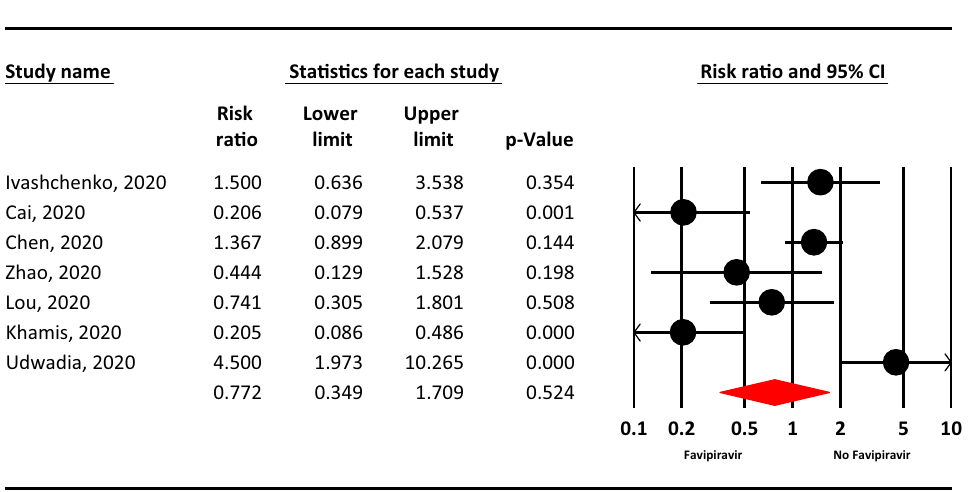
Figure 5. The meta-analysis of adverse events of Favipiravir on COVID-19 patients (red diamond: summery of